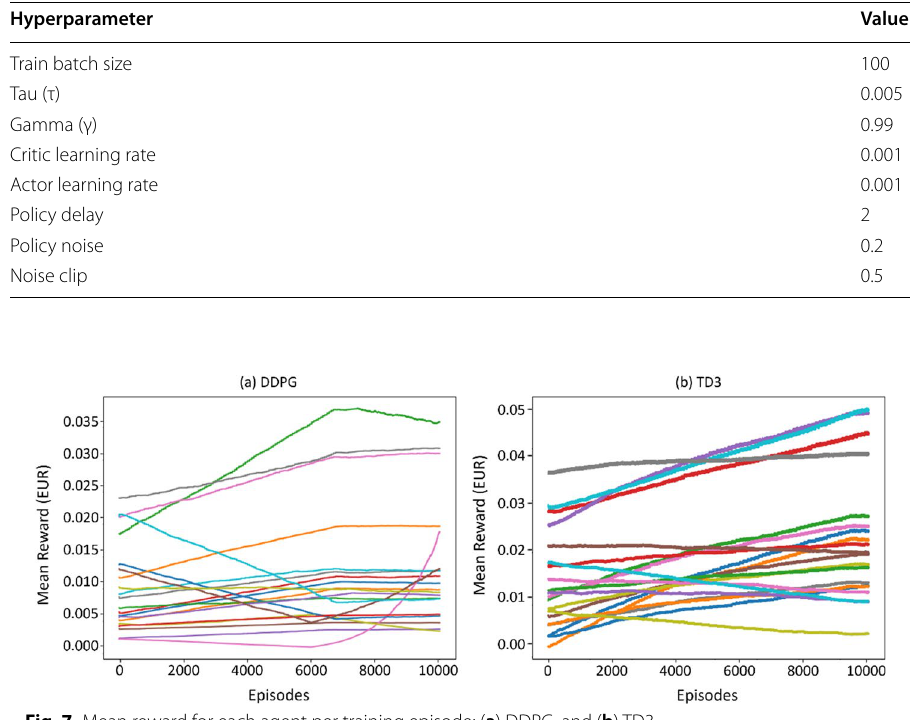
Table 1 TD3 and DDPG training hyperparameters